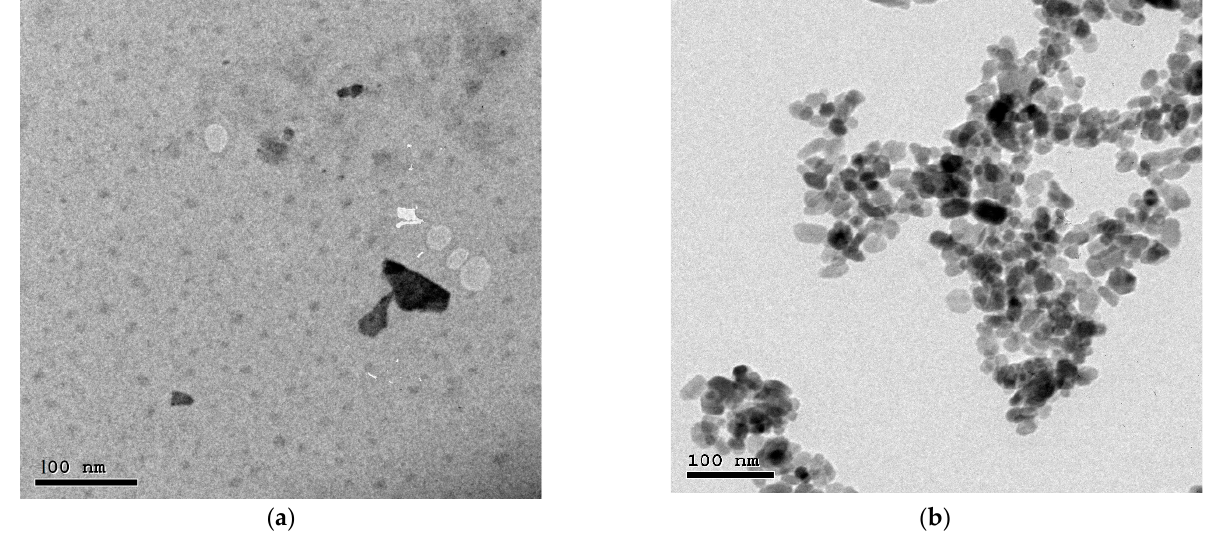
2 O 3 NPs and ( b ) WO 3